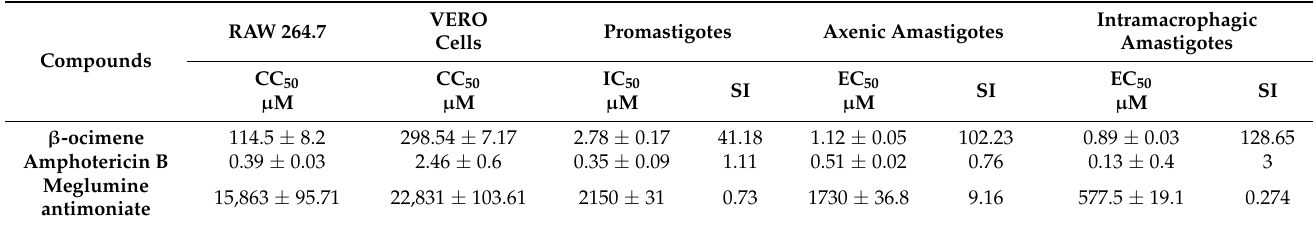
Table 2. Effect of β -ocimene and reference drugs on RAW 264.7 macrophage and Vero cell viability, an- tileishmanial activity, and selectivity index (SI). Data represent the average ± standard error for three independent experiments performed in triplicate. The differing mean concentrations against pro- mastigote (IC 50 ), axenic amastigote, and intra-macrophagic amastigote (EC 50 ), macrophages, and Vero cells (CC 50 ) were calculated using non-linear regression. SI (selectivity index) = CC 50 Raw 264.7 /IC 50 or EC 50